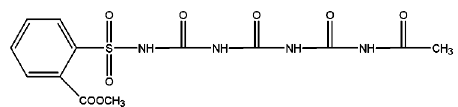
FIGURE 5 . 1[2-methoxy-benzene-1-sulfonyl]-7-acetyltriuret.